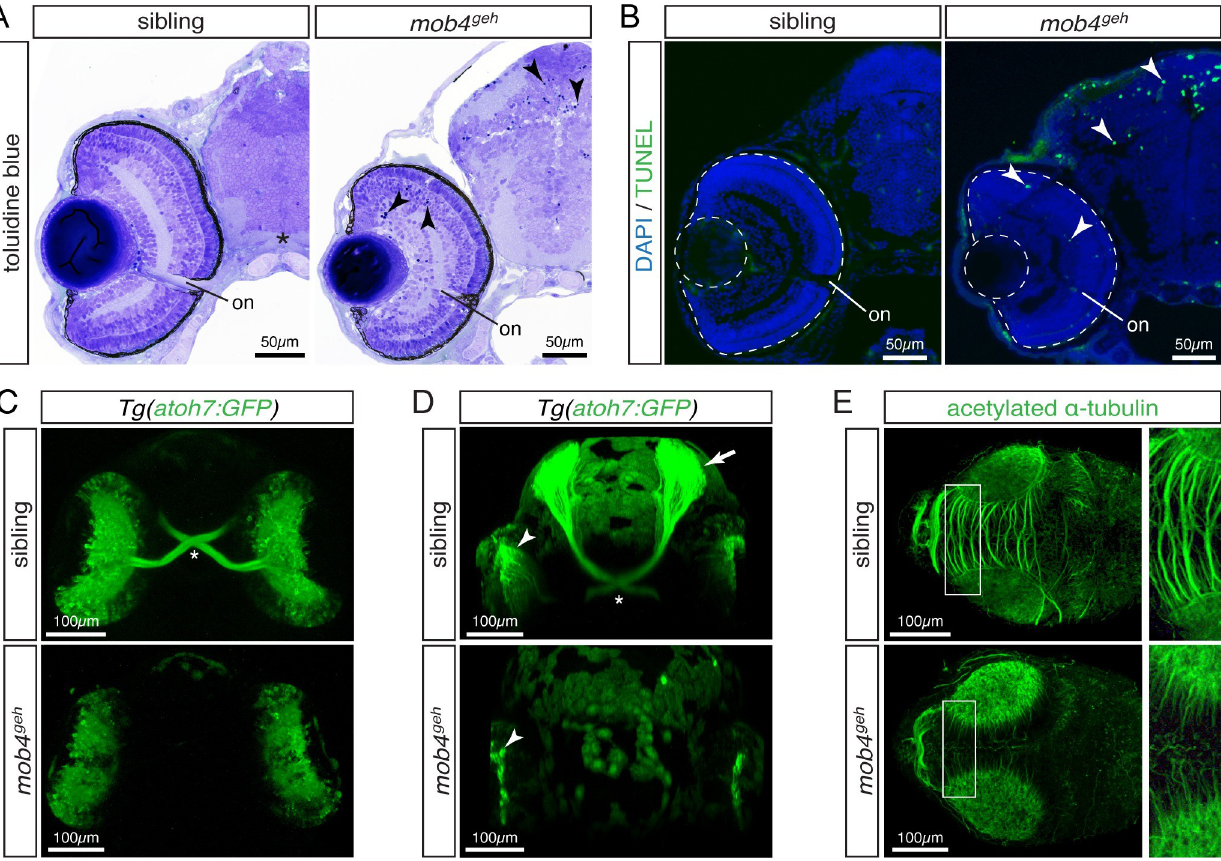
Fig 6. Loss of mob4 function compromises neuronal connectivity. (A) At 3 dpf, toluidine blue-stained sections displayed pyknotic nuclei (arrowhead) dispersed throughout the retina and tectum of mob4 geh homozygotes, not siblings (n = 4 per genotype). (B) Abundant apoptosis within the retina and tectum of 3-dpf-old mob4 geh homozygotes was detected by TUNEL assay (n = 8 per genotype). (C) In representative ventral views (Z-stack), the optic chiasm (asterisk) was highlighted by Tg(ath7 : GFP) within 3-dpf-old siblings but not mob4 geh homozygotes (n = 3 per genotype). (D) In representative Z- stacks, axons of retinal ganglion cell marked by Tg(ath7 : GFP) project contralaterally via the optic chiasm (asterisk) from the retina (arrowhead) onto the tectum (arrow) of 3-dpf-old siblings (n = 4). In contrast, axons were not formed by retinal ganglion cells (arrowhead) of mob4 geh homozygotes (n = 4). (E) In Z-stacks of 3-dpf-old larvae, antibodies against acetylated α -tubulin revealed defective neurite formation within the tectum of mob4 geh homozygotes. Boxed areas are shown in higher magnification (n = 3 per genotype). Scale bar sizes are indicated.